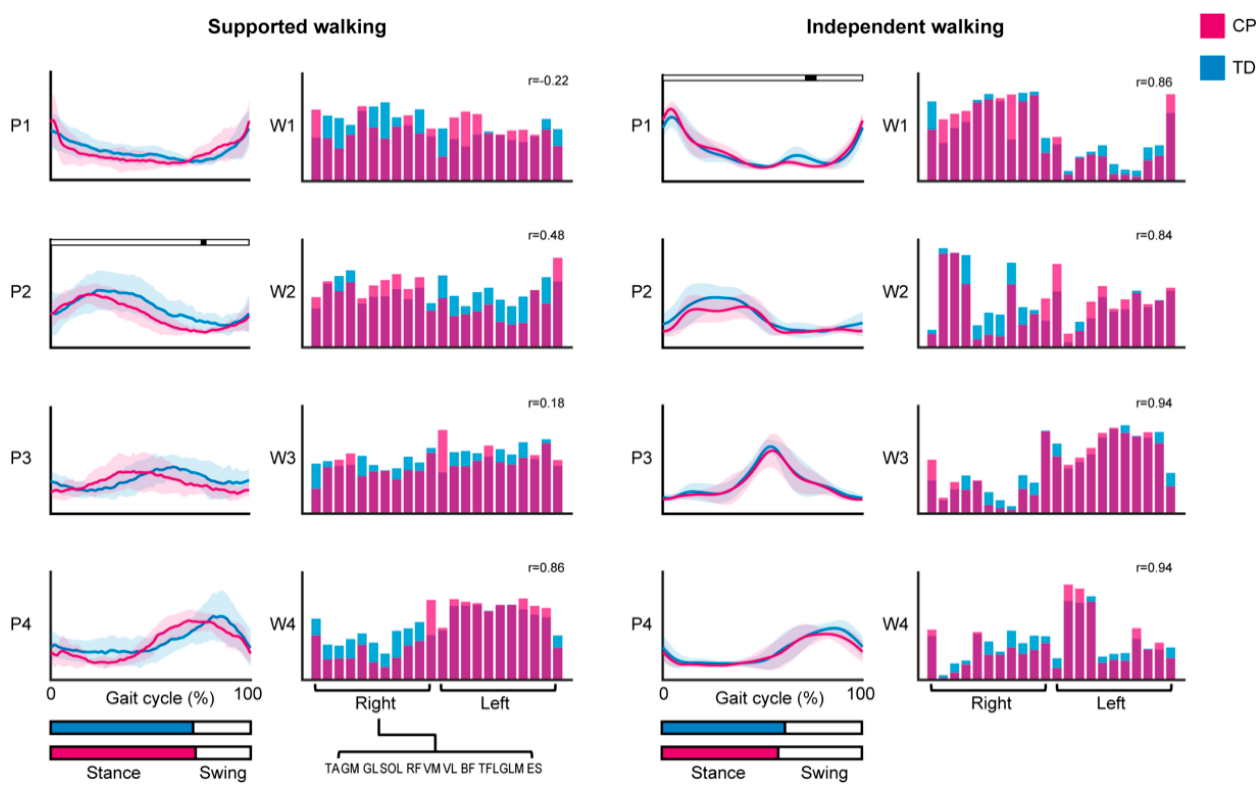
Figure 2. Mean activation patterns and synergy weights for a fixed number of four synergies. Bilateral EMG analysis results of the cerebral palsy (CP) and typically developing (TD) group, for supported walking ( left ) and independent walking ( right ). Lines show the mean temporal activation patterns (P) ± SD along the gait cycle, with mean stance and swing phase indicated by bar graphs at the bottom. Synergy weights (W) for the recorded muscles are depicted in a bar graph. Significant differences between activation patterns are indicated by the black bars, p < 0.05. Pearson’s correlations coefficients (r) between mean synergy weights of the CP and TD group are given. Abbreviations: TA = tibialis anterior; GM = gastrocnemius medialis; GL = gastrocnemius lateralis; SOL = soleus; RF = rectus femoris; VM = vastus medialis; VL = vastus lateralis; BF = biceps femoris; TFL = tensor fascia latae; GLM = gluteus maximus; ES = erector spinae at L2 level.